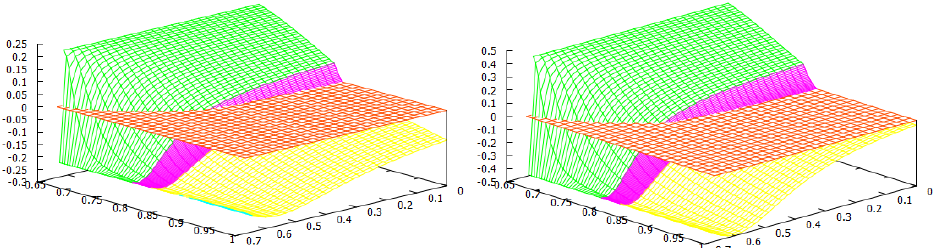
Figure 5. Left : The Nash social welfare share difference ∆ ShW j of country X j with respect to the welfare Nash and social tariffs. Right : The Nash social profit share difference ∆ Sh π j of country X j . See Equations (14) and (18).